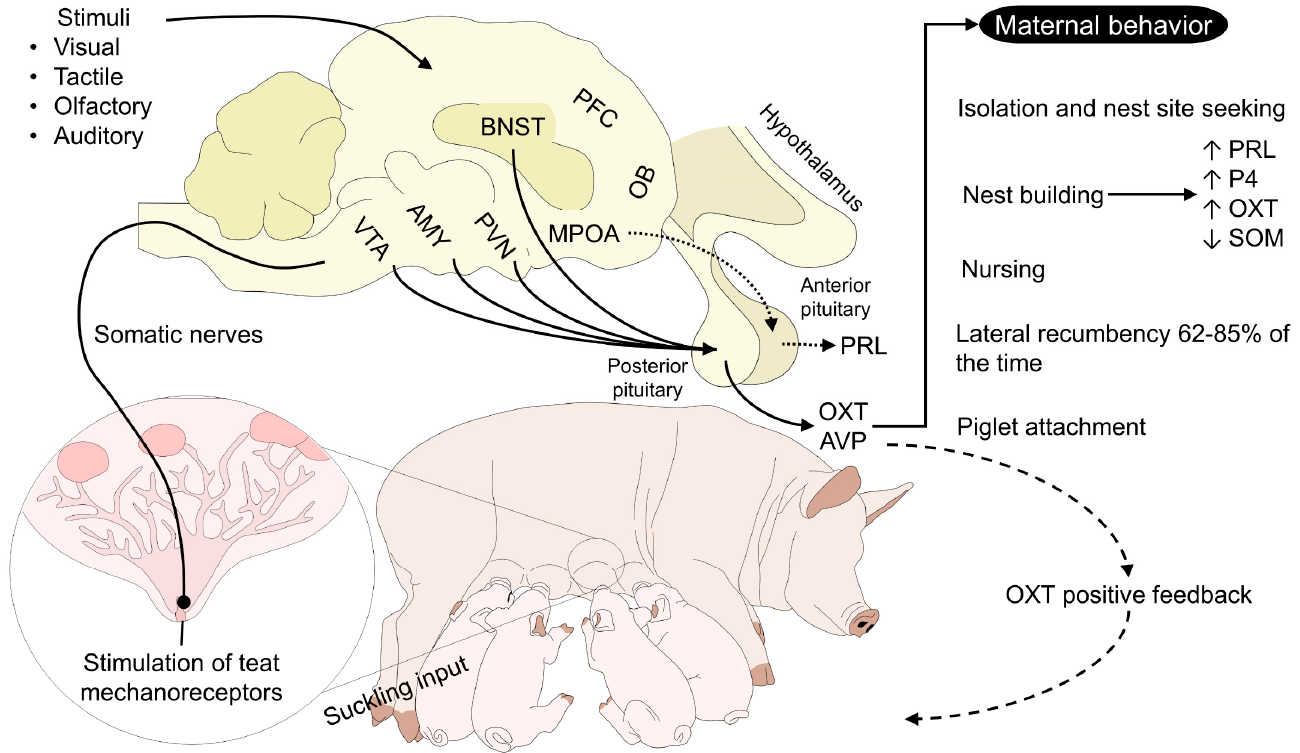
Figure 3. The oxytocinergic positive feedback loop of maternal behavior in sows. The visual, tactile, olfactory, and auditory stimuli that are constantly perceived by the sow participate in maternal responsiveness and attachment due to the activation of vital cerebral regions sensitive to OXT. For example, stimulation and activation of AMY, BNST, PVN, and VTA promote OXT release in the posterior pituitary. After OXT is released, several peripartum maternal behaviors in mammals are influenced by this hormone. In the case of sows, increases in circulating OXT levels before the onset of farrowing motivate nest site seeking and nesting. Particularly, nest building has also been associated with high concentrations of OXT, P4, PRL, and low levels of SOM in aforementioned cerebral regions. After farrowing, the development of maternal attachment and nursing of the piglets requires so-called OXT positive feedback, where piglets stimulate teat mechanoreceptors through suckling, releasing OXT in the maternal brain and promoting maternal behaviors. On the other hand, MPOA axons project to the anterior pituitary to release PRL and participate in milk secretion. AMY: